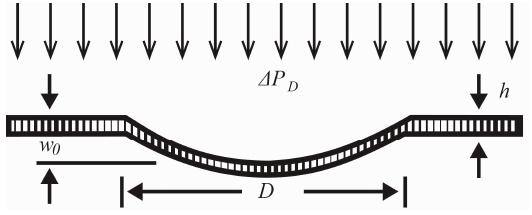
Figure A4. Diagram of parameters for diaphragm deflection. Large deflection ( w 0 > h ) of diaphragms of diameter D under trans-diaphragm pressure Δ P D .